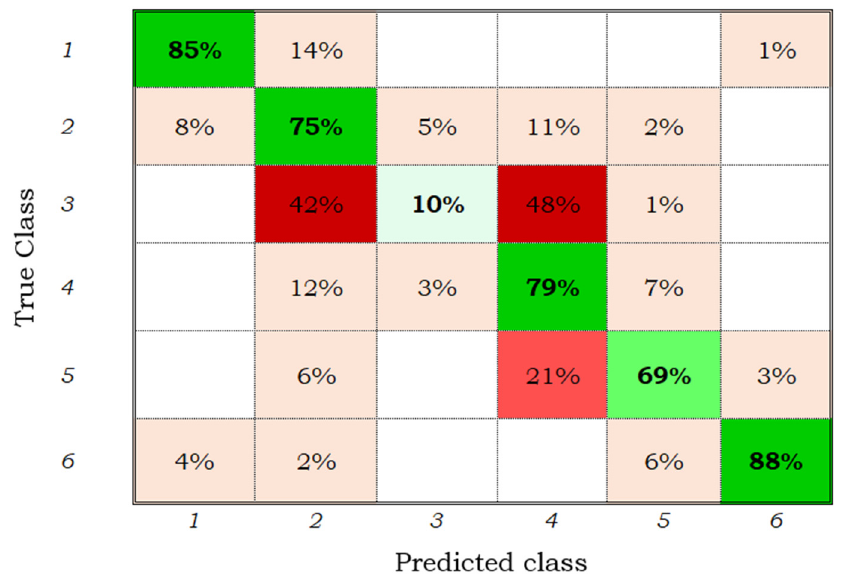
Figure 4. Confusion matrix of the quadratic SVM model for the six classes and 86 characteristics.